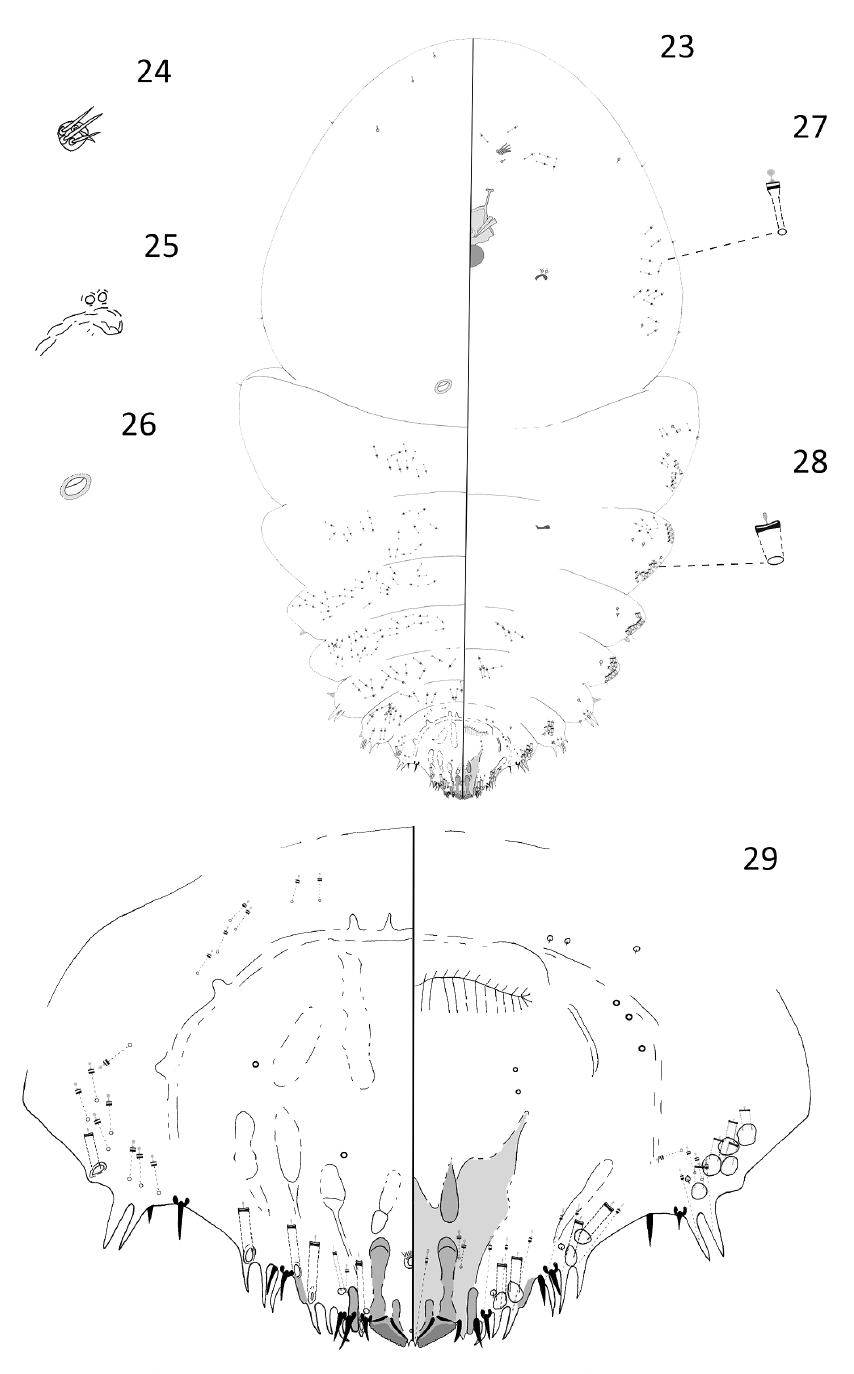
Figure 23–29. Andaspis ornata Hamilton and Williams, sp. n., adult female; 23 whole body 24 antenna 25 anterior spiracle 26 cicatrix 27 microduct 28 macroduct 29